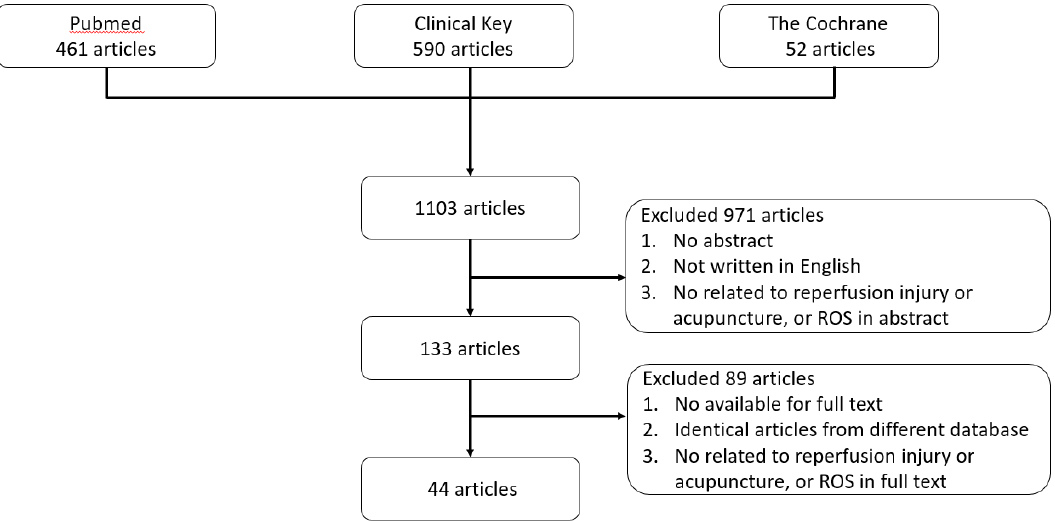
Figure 1. Flowchart of the search process.